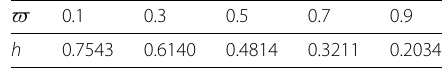
Table 2 Maximum allowable sampling period of h in Example 4.1